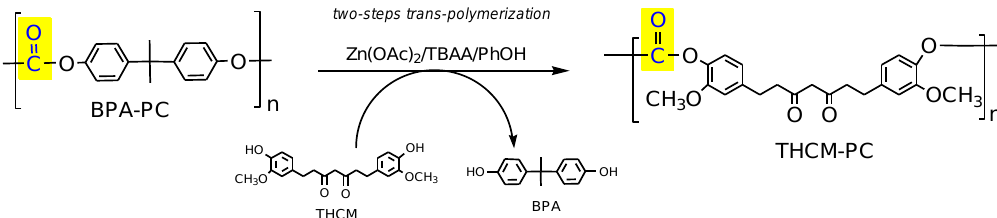
Figure 2. Scheme of the preparation process of THCM-PC, where the plastic waste BPA polycarbonate (BPA-PC) is converted into a renewable analogous in line with the needs of the circular economy. For the preparation of CM-PC, CM is used instead of tetrahydrogenated colorless product (THCM) in the trans-polymerization.